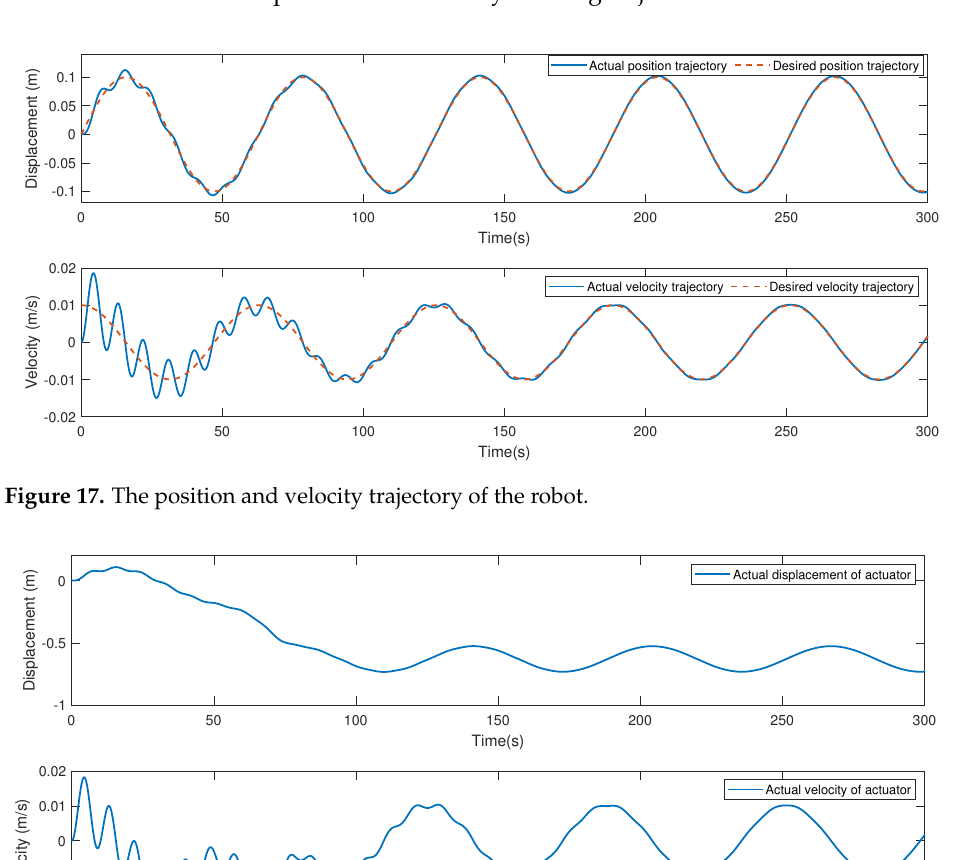
Figure 16. The position and velocity trajectory of the SEA actuator. Then, the desired trajectory is tuned. The desired trajectory for a human knee joint is specified as z d = 0.1 sin ( 0.1 t ) . The main parameters are chosen as γ 1 = 0.95, γ 2 = 1.2, α 1 = 1, g = 9.8 m/s 2 , ζ 1 = 3, and ζ 2 = 1. The results are depicted in Figures 17 and 18. It can be seen that desired position and velocity tracking trajectories can be tracked.